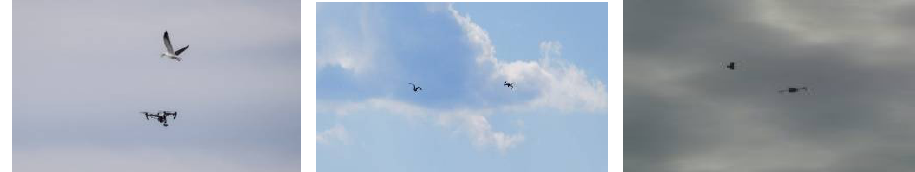
Figure 1. Some samples of challenges related to the resemblance of drones and birds.